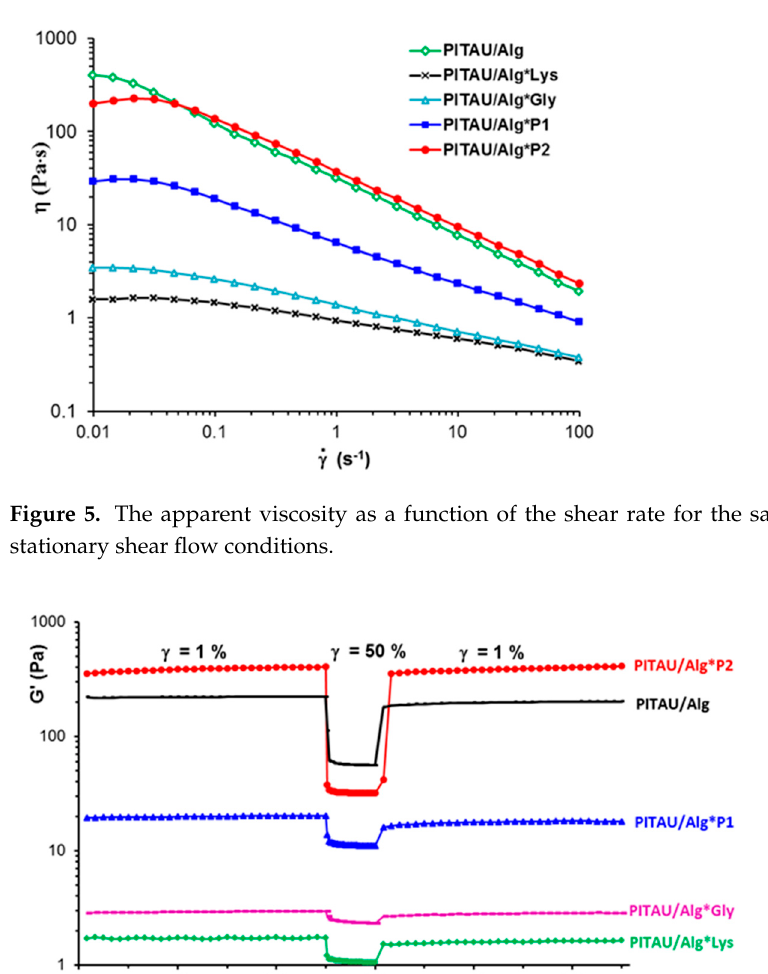
( b ) Figure 4. The elastic ( a ) and viscous ( b ) moduli as a function of the oscillation frequency for the